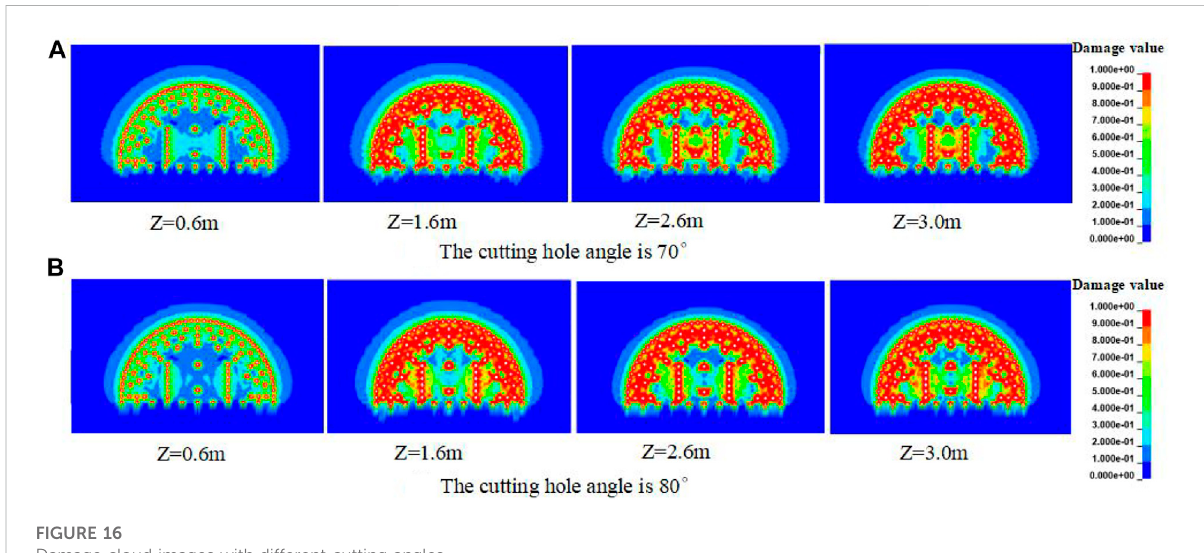
FIGURE 16 Damage cloud images with different cutting angles.